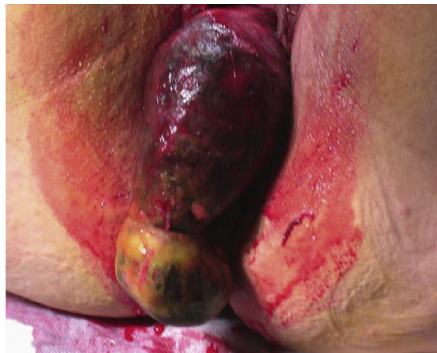
Figure 1: Macroscopic appearance of a complete nonpuerperal uterine inversion due to a fibroid